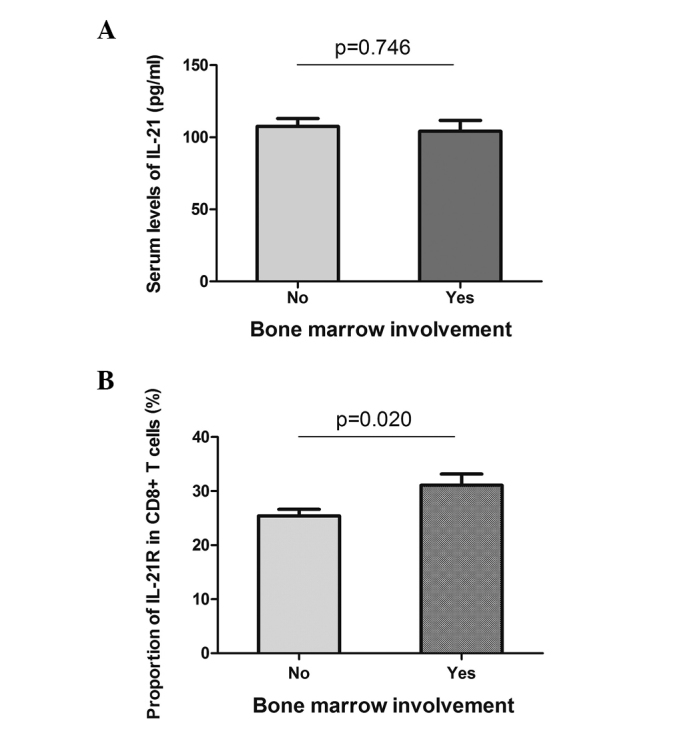
(A) Serum levels of IL-21 and (B) IL-21R expression on peripheral CD8+ T cells in the patients with DLBCL with a different status of bone marrow involvement. P-values of each comparison are shown. IL-21, interleukin 21; IL-21R, IL-21 receptor; CD8, cluster of differentiation 8; DLBCL, diffuse large B-cell lymphoma.